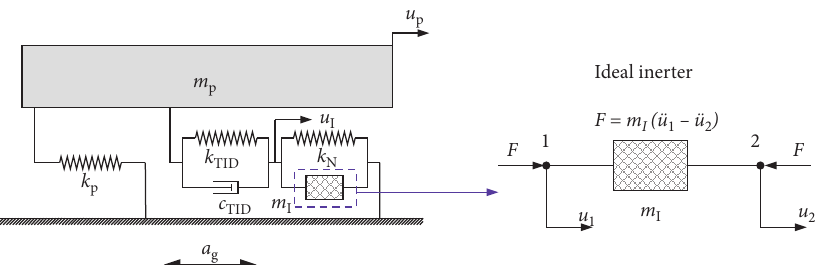
Figure 1: Analytical mechanical model of TID_NSD under harmonic support excitation with fixed-acceleration amplitude.